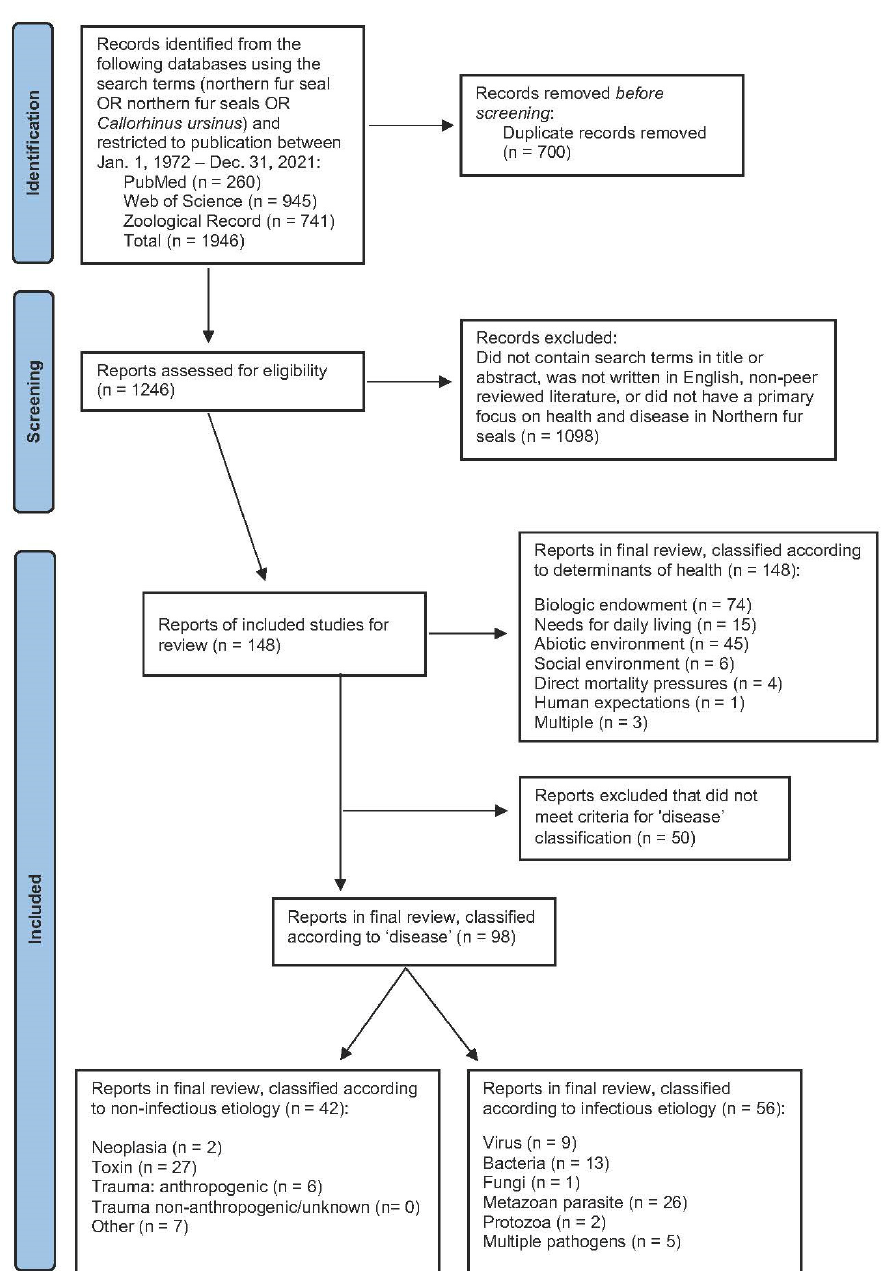
Figure 1. Schematic representation of the scoping literature process including original searches through to classification of articles by determinants of health, as well as subcategories of disease.